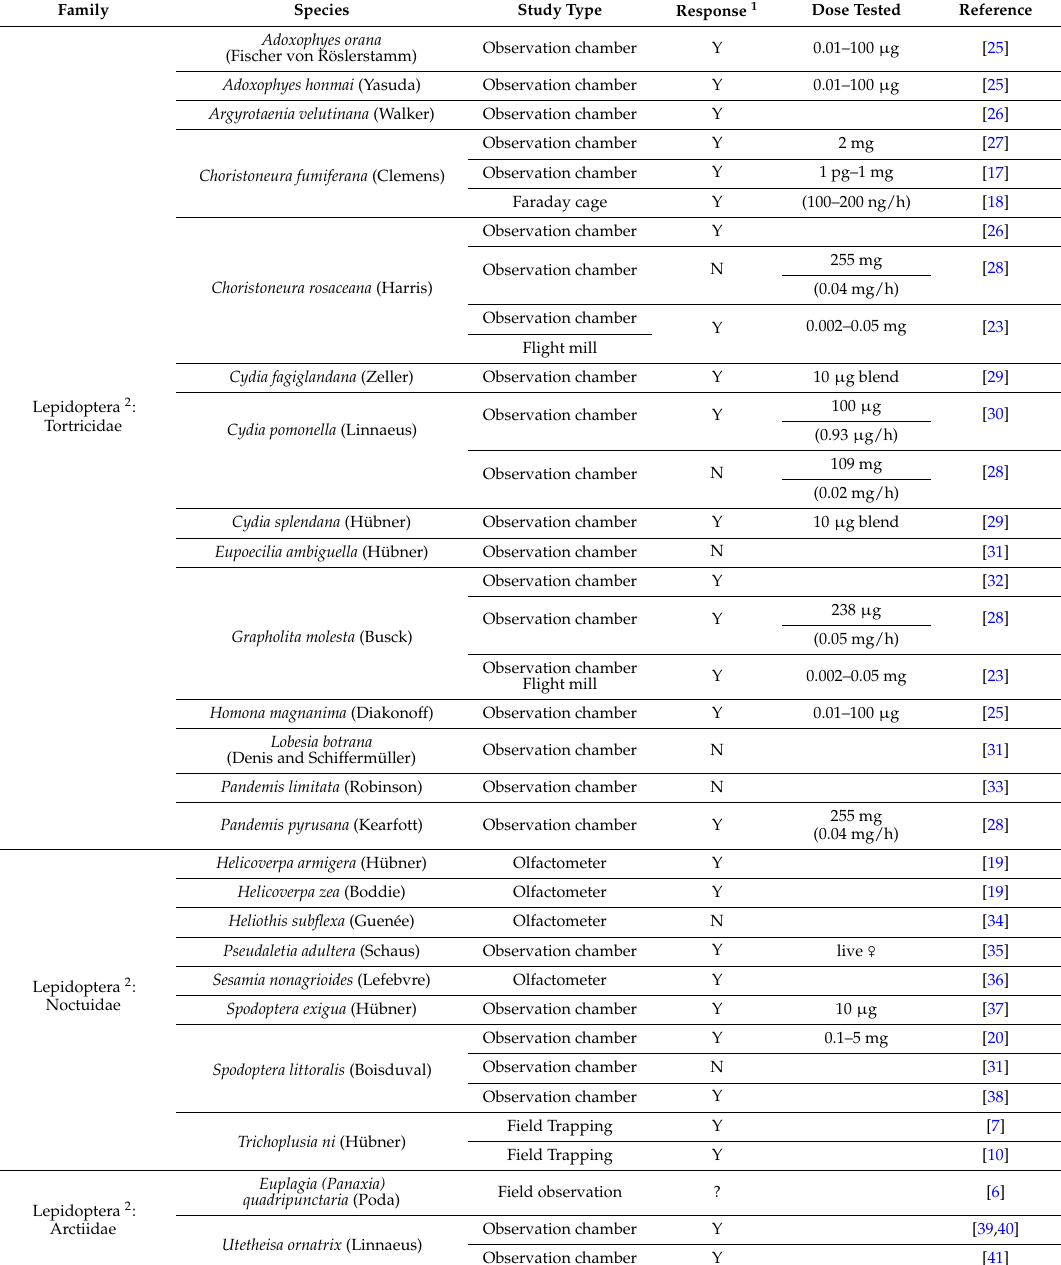
Table 1. Behavioral responses of females to conspecific sex